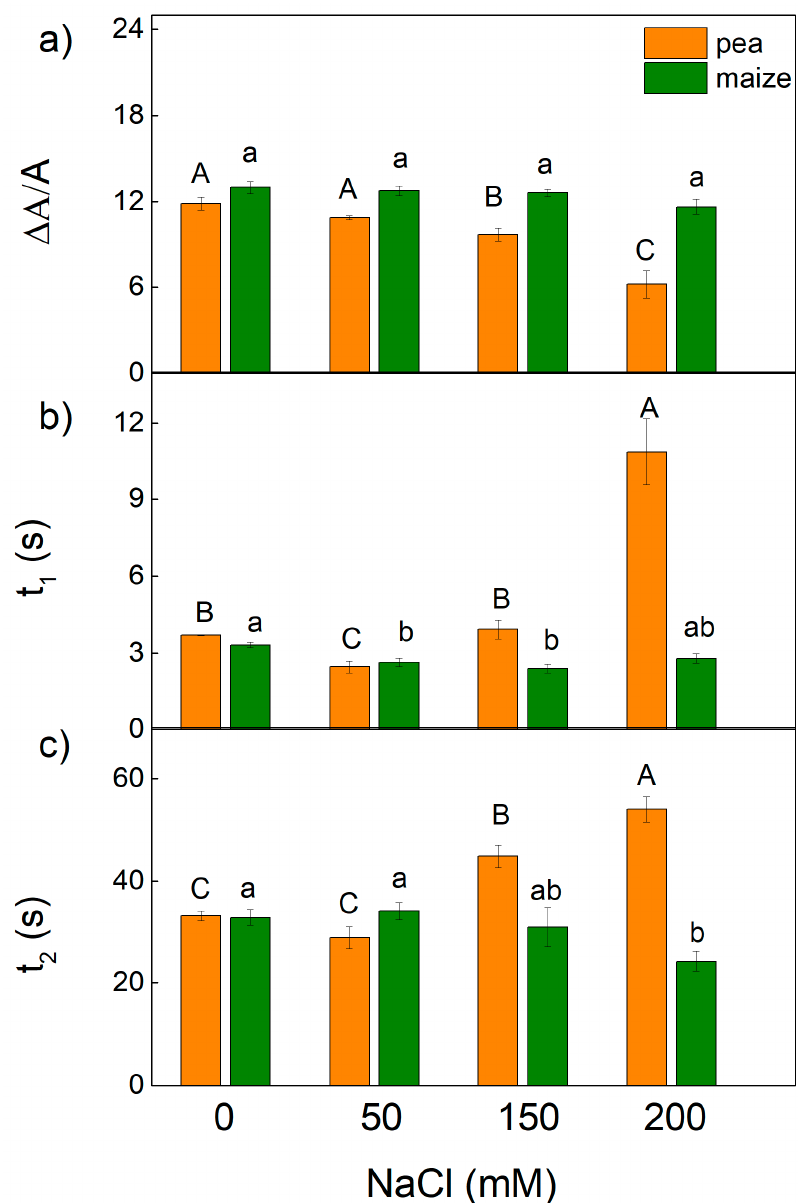
Figure 10. Effects of different NaCl concentrations on the far-red light-induced oxidation of P 700 ( ∆ A/A) (the parameter is in relative units) ( a ), and the times of fast t 1 ( b ) and slow t 2 ( c ) of two components of dark reduction in the P 700+ in leaves of pea and maize. Mean values ( ± SE) are from 10 independent measurements. Different letters indicate significant differences for the respective parameters at p < 0.05 (uppercase for pea and lowercase for